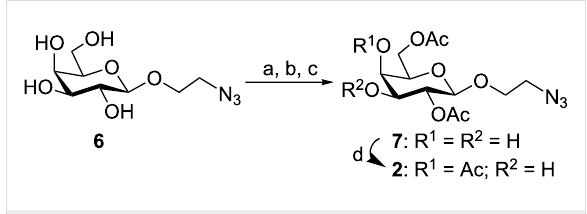
of macromolecules such as exopolysaccharides (EPS), lipopolysaccharides (LPS) and capsular polysaccharides